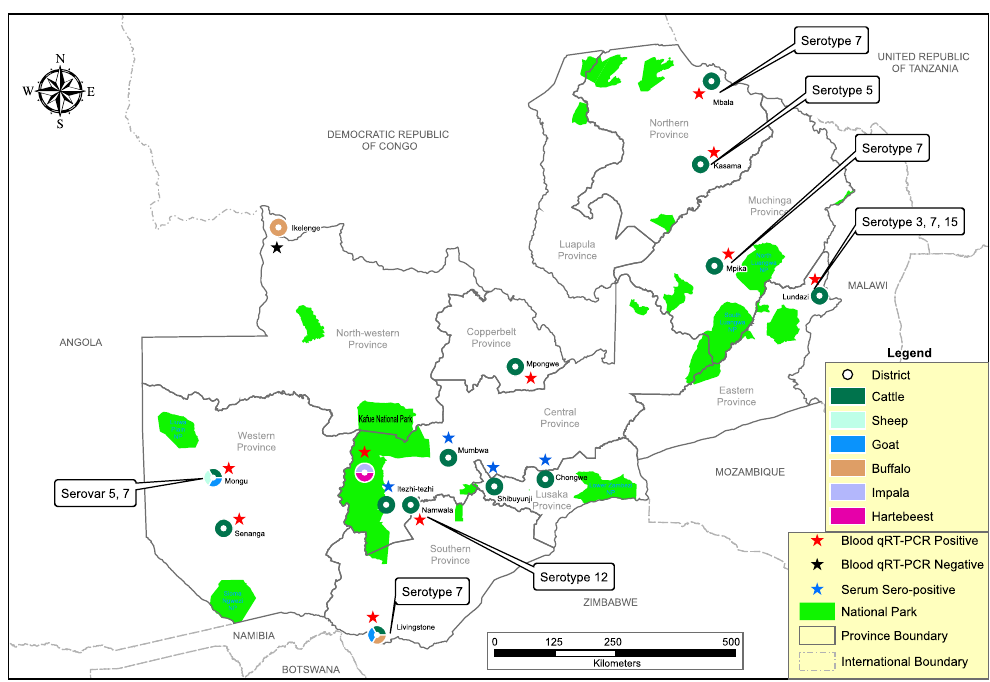
Figure 1. Map showing sample collection sites, bluetongue virus nucleic acid detection, antibody and serotyping results in selected districts and provinces of Zambia .